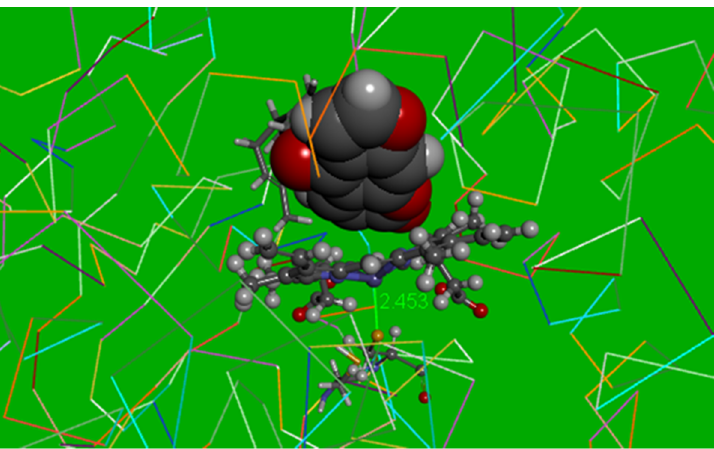
Figure 18. Output of the standard dynamic cascade of bergamottin pose 6 interaction with CYP3A4, showing iron coordination number 5 (the iron is out of the heme plane). The CPK planar moiety is bergamottin. The protein is in the C-alpha wireframe.